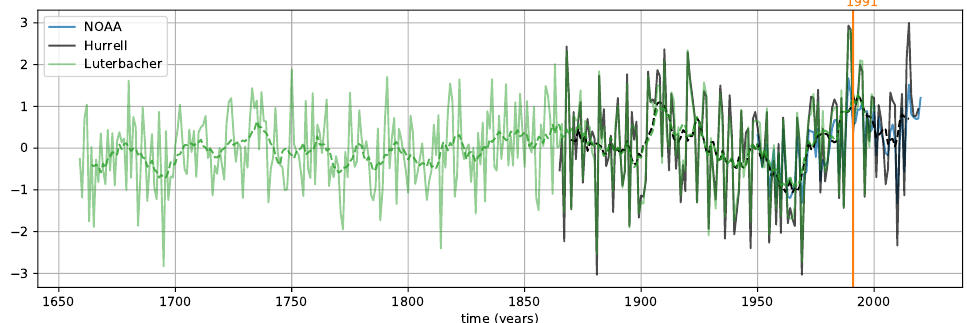
Figure 6. Station-based NAO index [55,65] (black line) calculated as the difference of normalized sea level pressure (SLP) between Lisbon, Portugal, and Stykkisholmur/Reykjavik, Iceland since 1864. A 7-year average of this station-derived index is plotted (black dashed line). The Luterbacher et al. [62] index, constructed from a combination of instrumental station pressure, temperature, and pre- cipitation measurements and proxy data back to 1659 is also shown (green line, and 7-year run- ning average: dashed green line). An EOF-based NAO index obtained from the NOAA website https://www.cpc.ncep.noaa.gov/products/precip/CWlink/pna/nao.shtml (accessed on 10 October 2021) calculated with the Rotated Principal Component Analysis technique [56] was applied to monthly mean standardized 500 mb height anomalies obtained from the Climate Data Assimilation System in the analysis region 20 ◦ N–90 ◦ N between January 1950 and December 2000. The starting date for the satellite altimetry era (1991) is also